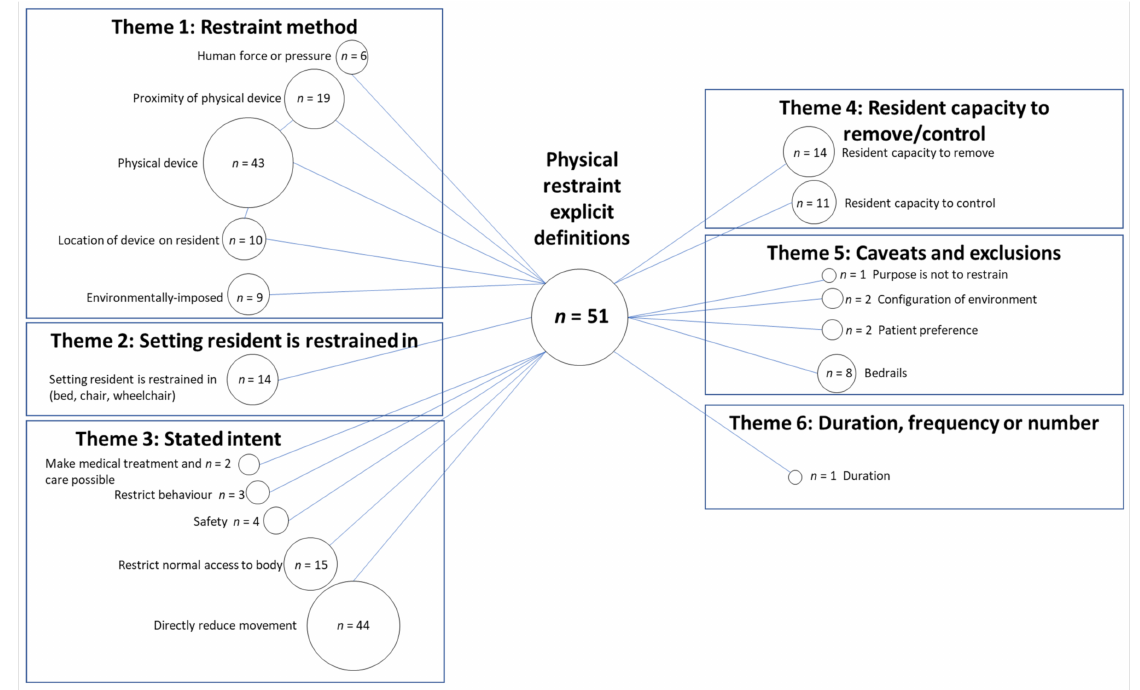
Figure 2. Codes and themes present within explicit definitions of physical restraint. n = number of explicit definitions for which this code was identified as being a part of the